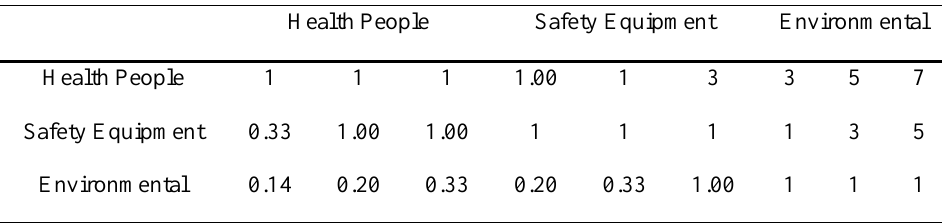
Table 6. Pair comparison of criteria .